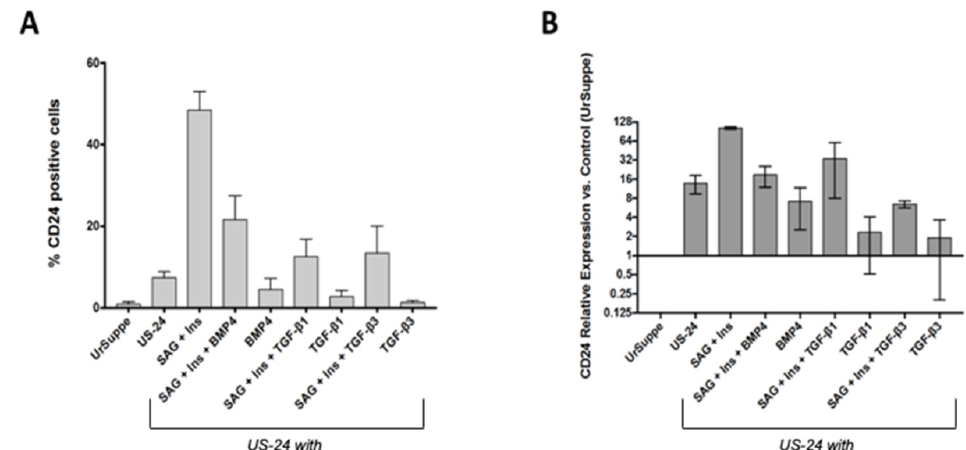
Figure 5. TGF family members downregulate the CD24 antigen. Analysis by flow cytometry and RT-qPCR of the expression of this surface protein. Human ASCs were cultured for 5 days in the US-24 medium combined with the factors depicted on the x -axis. ( A ) Flow cytometry analysis: Percentage of CD24-positive hASCs depending on the factors displayed on the x -axis ( n = 3, error bars represent S.E.M., complete statistical significance reported in Supplementary Materials Table S5). ( B ) CD24 mRNA expression measured by RT-qPCR. The cells were cultured and treated as in ( A ), the normalized expression ratios found with the eight cell culture conditions depicted on the x -axis were related to the value obtained with hASCs grown in UrSuppe medium ( n = 3, error bars